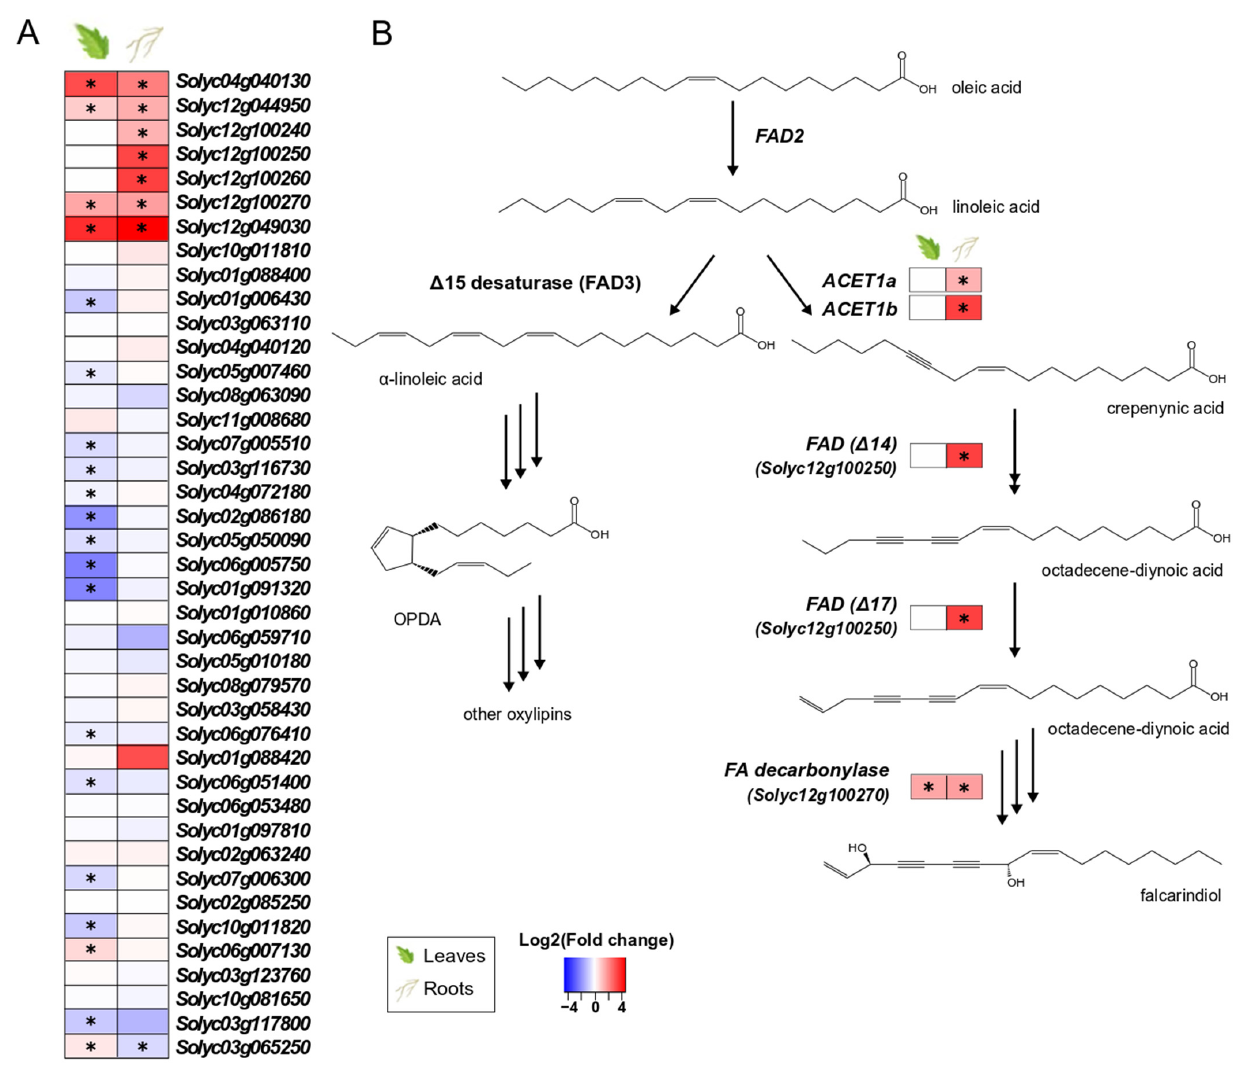
Figure 4. Tomato putative fatty-acid desaturases (FADs) involved in the biosynthesis of fatty acids in leaves and roots. ( A ). Changes in gene expression between tissues from inoculated plants and tissues from endophyte-free plants are represented as log 2 of the fold change in the form of a heatmap. Data derived from RNA sequencing on leaves and roots from S. indica - and mock-inoculated plants. Asterisks (*) indicate FDR-corrected p ≤ 0.05. ( B ). Biosynthetic pathway leading to oxylipins (left) and falcarindiol (right). Linoleic acid is used in the biosynthesis of jasmonic acid and other oxylipins, as well as the production of highly modified fatty acids (polyacetylenes). Proposed chemical structures, gene function and biosynthetic pathway are based on the work of [51].